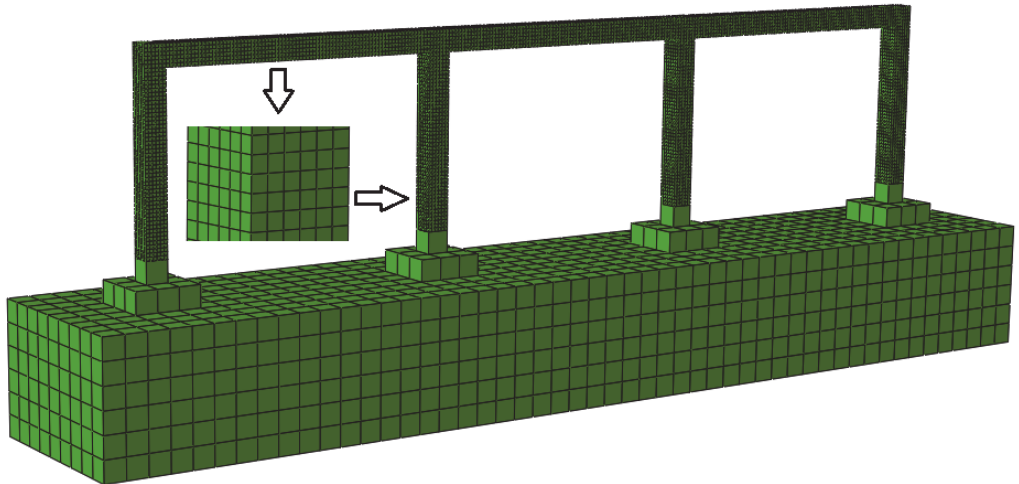
Figure 3: The mesh is developed for the numerical simulation